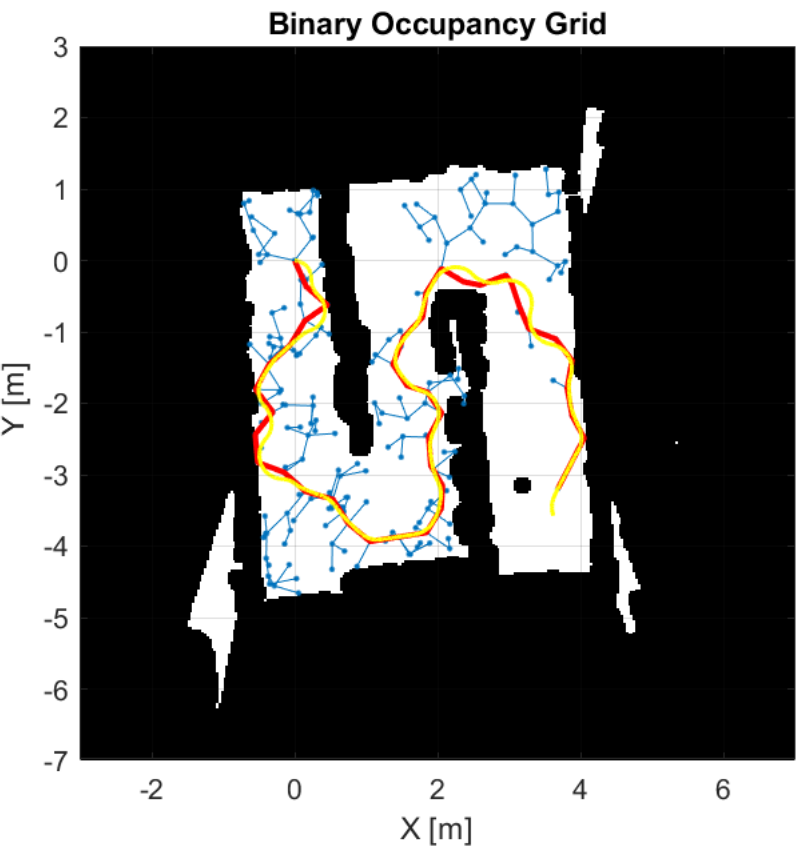
Figure 27. Desired waypoints obtained with RRT algorithm and path obtained from odometry data.